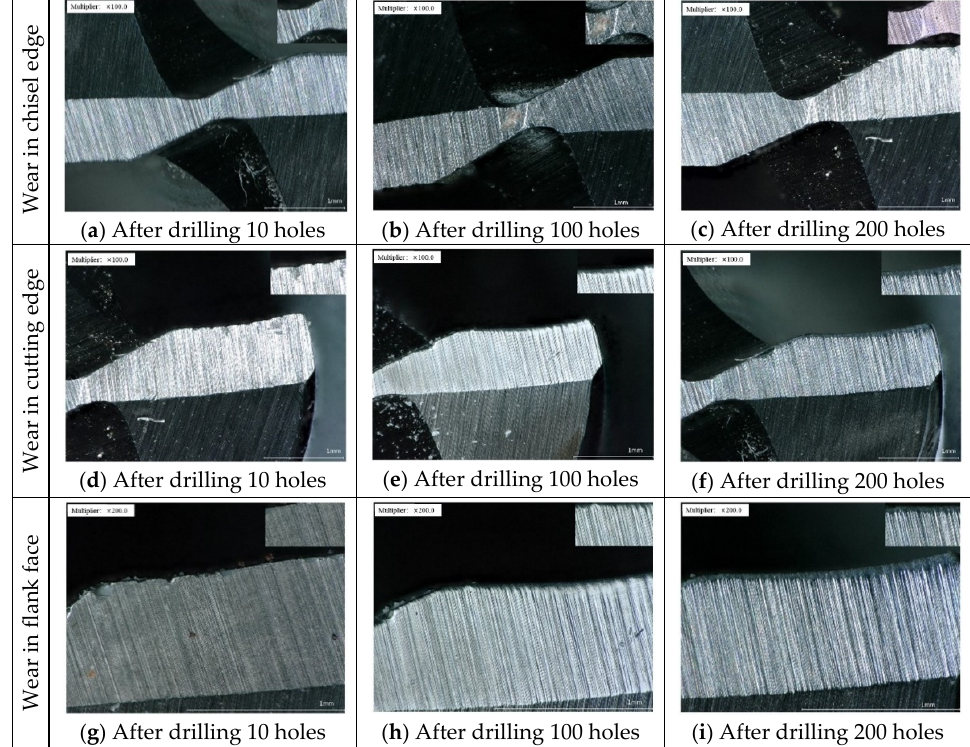
Figure 8. Wear morphologies of different parts of the drill bit ( Vc = 85 m/min, f = 30 mm/min).